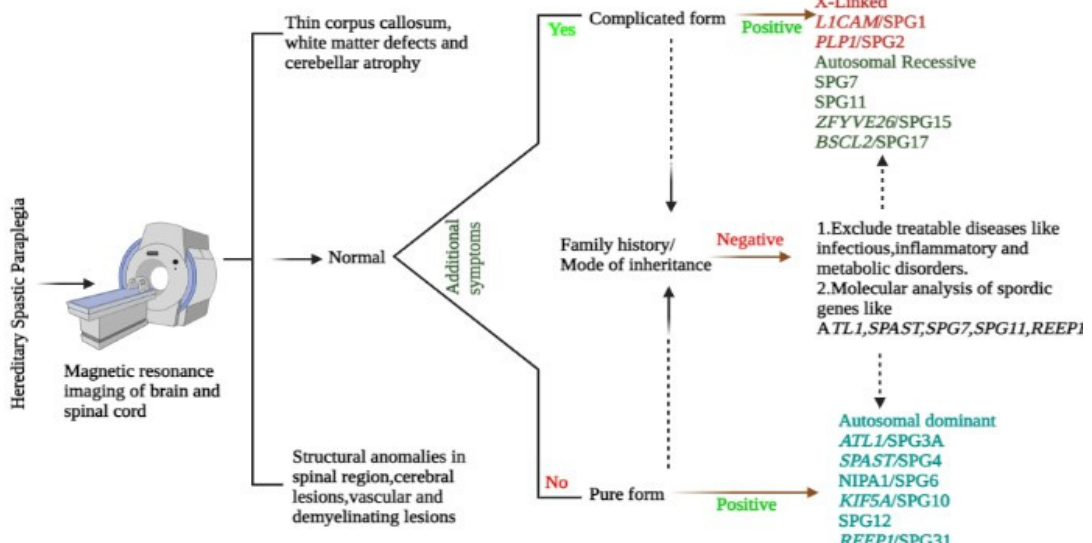
Figure 3. Elucidates the diagnostic protocol followed to identify HSP patients and other neurologi- Figure cal disorders.